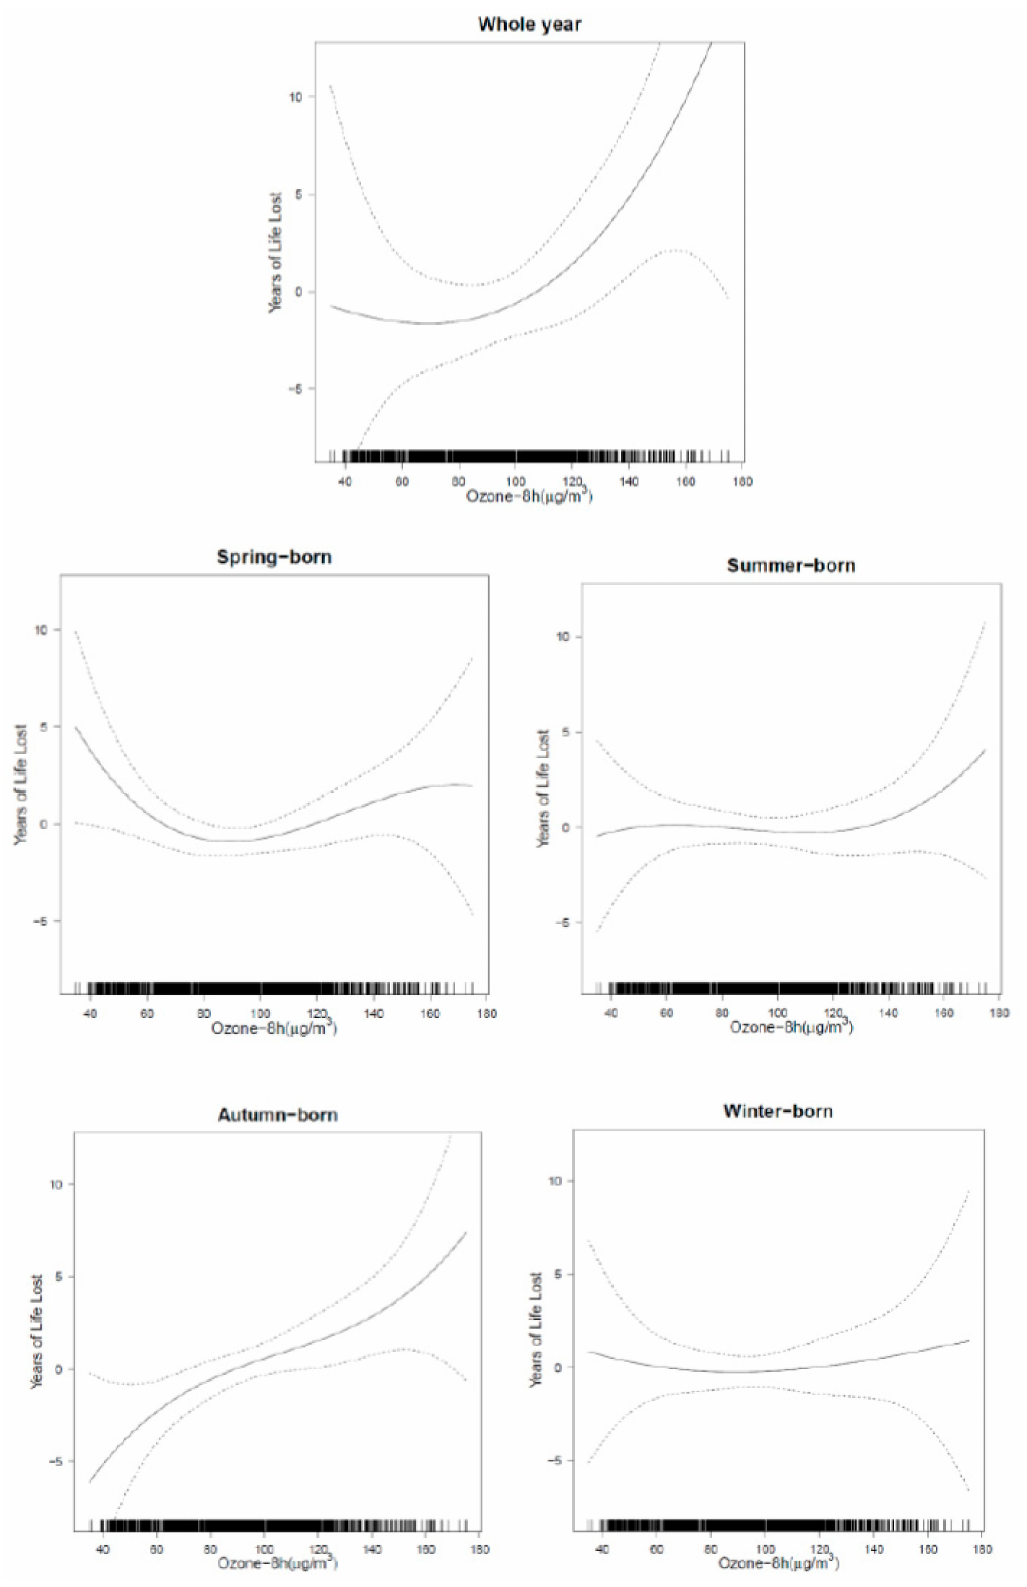
Figure 3. Exposure–response curves of ozone and years of life lost from hypertension in the elderly individuals born in di ff erent seasons in Ningbo, China, from 2013 to